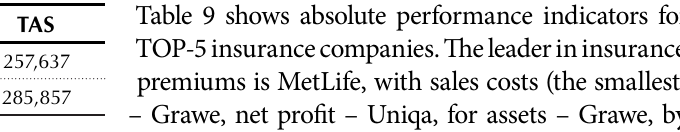
Table 8. Value of insurance premiums to expenses of life insurance companies